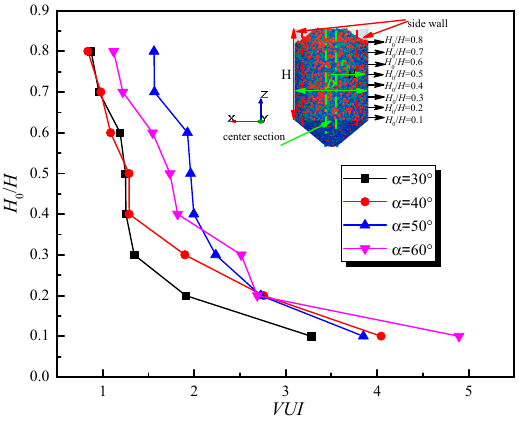
Figure 19. The variation in VUI with sinter layers for different half hopper angles.